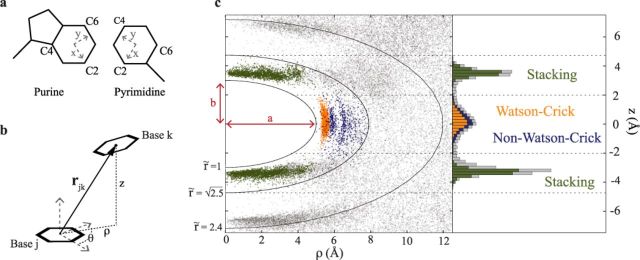
(a) Definition of the local coordinate system for purines and pyrimidines. (b) The vector \documentclass[12pt]{minimal}
\usepackage{amsmath}
\usepackage{wasysym}
\usepackage{amsfonts}
\usepackage{amssymb}
\usepackage{amsbsy}
\usepackage{upgreek}
\usepackage{mathrsfs}
\setlength{\oddsidemargin}{-69pt}
\begin{document}
}{}$\bf {r}_{jk}$\end{document} describes the position of base ring k in the coordinate system constructed on base ring j and is expressed in cylindrical coordinates ρ, θ, \documentclass[12pt]{minimal}
\usepackage{amsmath}
\usepackage{wasysym}
\usepackage{amsfonts}
\usepackage{amssymb}
\usepackage{amsbsy}
\usepackage{upgreek}
\usepackage{mathrsfs}
\setlength{\oddsidemargin}{-69pt}
\begin{document}
}{}$z$\end{document}. (c) Observed positions of neighboring bases in the crystal structure of the H. marismortui large ribosomal subunit projected on the \documentclass[12pt]{minimal}
\usepackage{amsmath}
\usepackage{wasysym}
\usepackage{amsfonts}
\usepackage{amssymb}
\usepackage{amsbsy}
\usepackage{upgreek}
\usepackage{mathrsfs}
\setlength{\oddsidemargin}{-69pt}
\begin{document}
}{}$z$\end{document}–ρ plane. Isolines of the ellipsoidal distance \documentclass[12pt]{minimal}
\usepackage{amsmath}
\usepackage{wasysym}
\usepackage{amsfonts}
\usepackage{amssymb}
\usepackage{amsbsy}
\usepackage{upgreek}
\usepackage{mathrsfs}
\setlength{\oddsidemargin}{-69pt}
\begin{document}
}{}$\tilde{r}$\end{document} are shown. Each point is colored according to the interaction type: canonical Watson-Crick pairs in orange, base–base non Watson-Crick pairs in blue and stacking in green. Base-sugar, base-phosphate and non-annotated pairs are shown in light gray. On the right, empirical distribution along the \documentclass[12pt]{minimal}
\usepackage{amsmath}
\usepackage{wasysym}
\usepackage{amsfonts}
\usepackage{amssymb}
\usepackage{amsbsy}
\usepackage{upgreek}
\usepackage{mathrsfs}
\setlength{\oddsidemargin}{-69pt}
\begin{document}
}{}$z$\end{document} coordinate obtained considering points with \documentclass[12pt]{minimal}
\usepackage{amsmath}
\usepackage{wasysym}
\usepackage{amsfonts}
\usepackage{amssymb}
\usepackage{amsbsy}
\usepackage{upgreek}
\usepackage{mathrsfs}
\setlength{\oddsidemargin}{-69pt}
\begin{document}
}{}$\tilde{r}<\sqrt{2.5}$\end{document}. Pairing and stacking regions can be unambiguously identified (|\documentclass[12pt]{minimal}
\usepackage{amsmath}
\usepackage{wasysym}
\usepackage{amsfonts}
\usepackage{amssymb}
\usepackage{amsbsy}
\usepackage{upgreek}
\usepackage{mathrsfs}
\setlength{\oddsidemargin}{-69pt}
\begin{document}
}{}$z$\end{document}| ≤ 2.0Å and |\documentclass[12pt]{minimal}
\usepackage{amsmath}
\usepackage{wasysym}
\usepackage{amsfonts}
\usepackage{amssymb}
\usepackage{amsbsy}
\usepackage{upgreek}
\usepackage{mathrsfs}
\setlength{\oddsidemargin}{-69pt}
\begin{document}
}{}$z$\end{document}| > 2.0 Å, respectively).